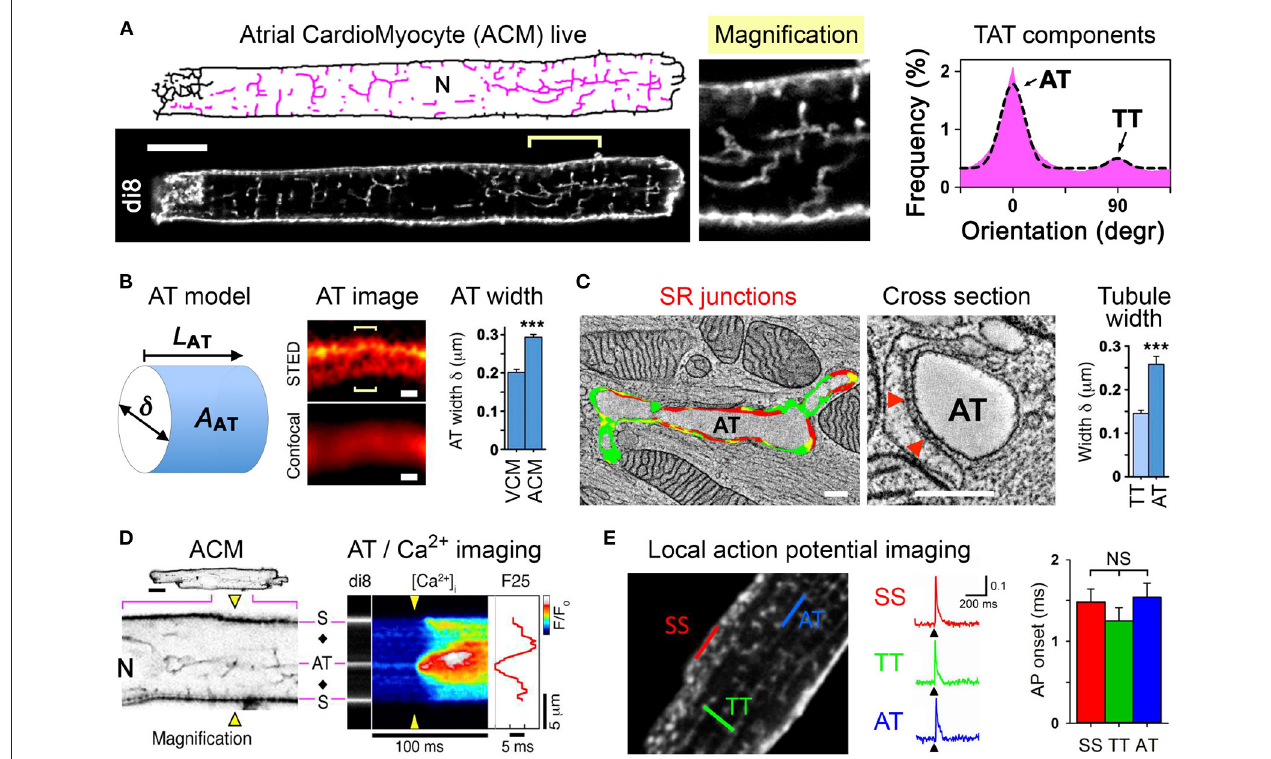
FIGURE 2 | A-tubules provide Ca 2+ signaling super-hubs for atrial excitation-contraction coupling. (A) Confocal live imaging of di-8-ANEPPS stained (di8) TAT structures visualized as skeleton (pink). N, nucleus. Scale bar 10 µ m. Histogram showing the TAT component orientations and Gaussian fit. Abundant AT (0 ◦ ) vs. sparse TT (90 ◦ ) components. (B) Cartoon of a cylindrical AT model. AT width ( δ ) measurements were used to estimate the surface area (AAT); LAT, AT component length. AT width was determined from optical cross sections (brackets) using the local STED signal distribution and compared between VCM vs. ACM as bar graph. Scales 200nm. (C) Electron tomography images and segmentation of a longitudinally sectioned and a cross-sectioned AT structure. Scales 200nm. Red color indicating AT-SR junctions ≤ 15nm in gap width containing RyR2 densities. Red triangles mark two exemplary electron densities compatible with RyR2 channels. (D) Confocal negative contrast visualization of intracellular AT structures and transversal line scanning (yellow triangles) of intracellular Ca 2+ imaging (fluo-4). A field potential-evoked Ca 2+ transient is activated at AT and subsurface (S) structures; black diamonds, off-membrane cytosolic sites; F25, Ca 2+ signal onset at 25% signal amplitude; 1 F / F 0 , normalized fluorescence intensity ratio as indicated by look-up-table; N, nucleus. (E) Two-photon action potential recordings from specific TAT components labeled with the voltage-sensitive dye di-4-ANE(F)PTEA (2 µ M). Normalized fluorescence traces ( 1 F / F 0 ) were recorded from the scan regions indicated by color. At AT, TT, and SS membranes structures the simultaneous action potential activation upon pacing (black arrowheads) is apparent. Grouped bar graph showing no significant difference for action potential onset (the time interval between the end of the stimulus and the rise of the fluorescence signal above a threshold of 4% 1 F / F 0 . AT, A-tubule; TT, T-tubule; SS, subsurface membrane site. NS, not significant. Adapted from Brandenburg et al.